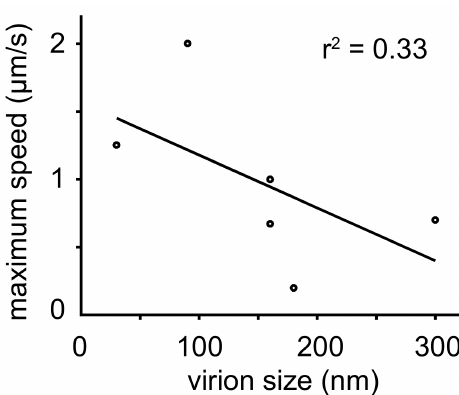
Figure 4. Plot of virion speed on microtubules versus particle size. Microtubule-based speed of viral particles inversely correlates with particle size. Reported maximum speeds and particle sizes are shown. For details and references, see Table 4.